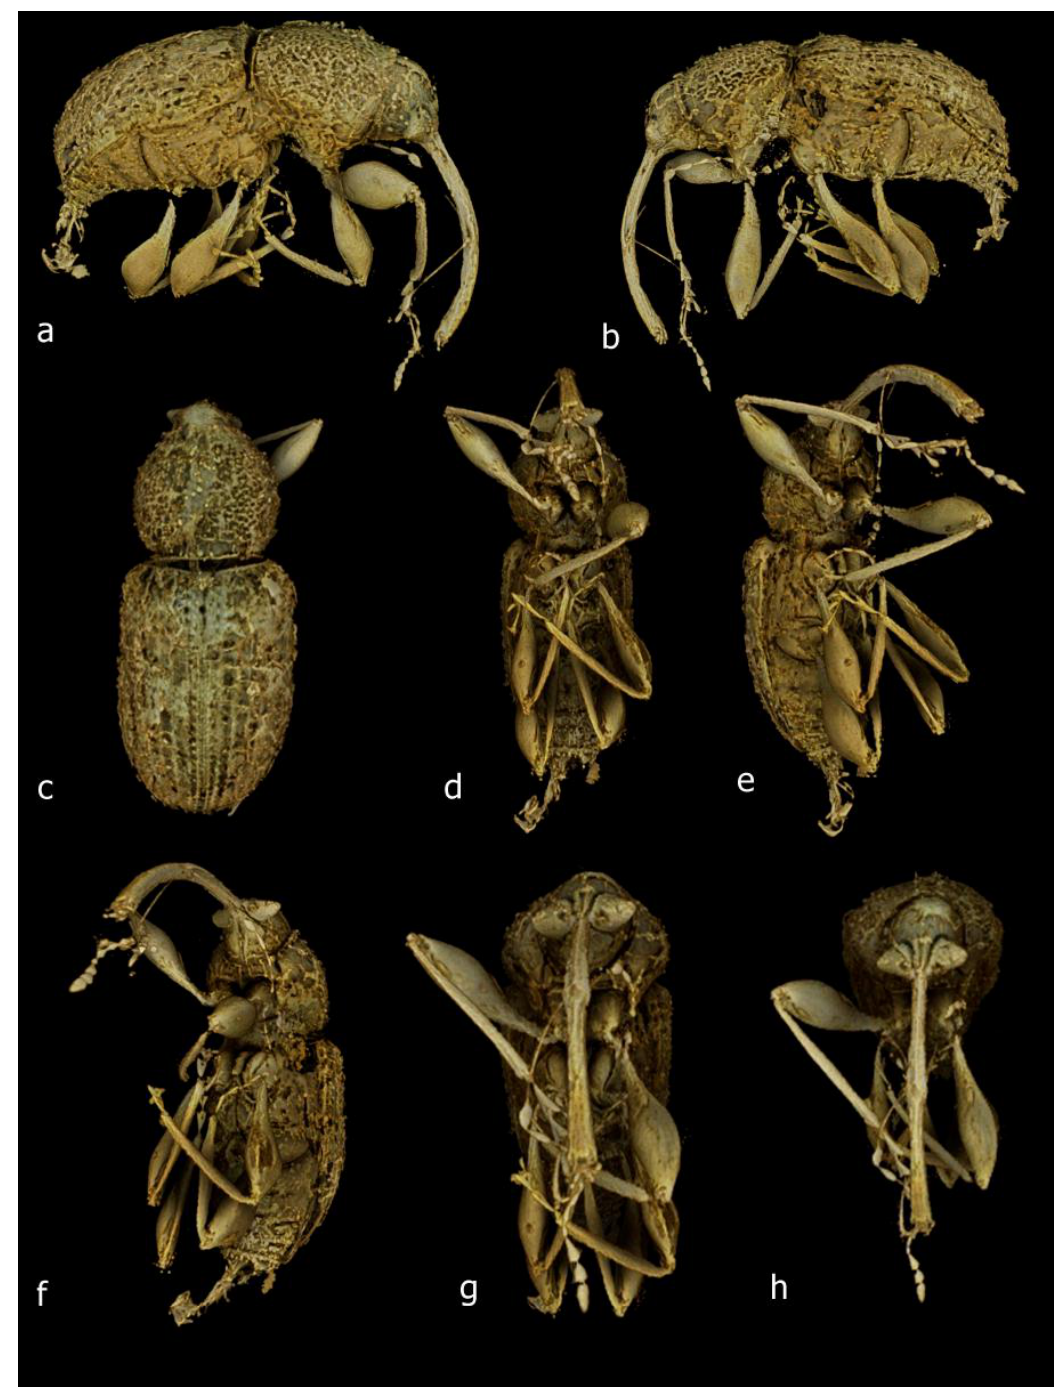
Figure 50. Debbia gracilirostris sp. n., holotype. Habitus images extracted from a micro-CT scanning reconstruction (see also Video S5). Right lateral ( a ); left lateral ( b ); dorsal ( c ); ventral ( d ); ventrolateral right ( e ); ventrolateral left ( f ); frontoventral ( g ); frontal ( h ).